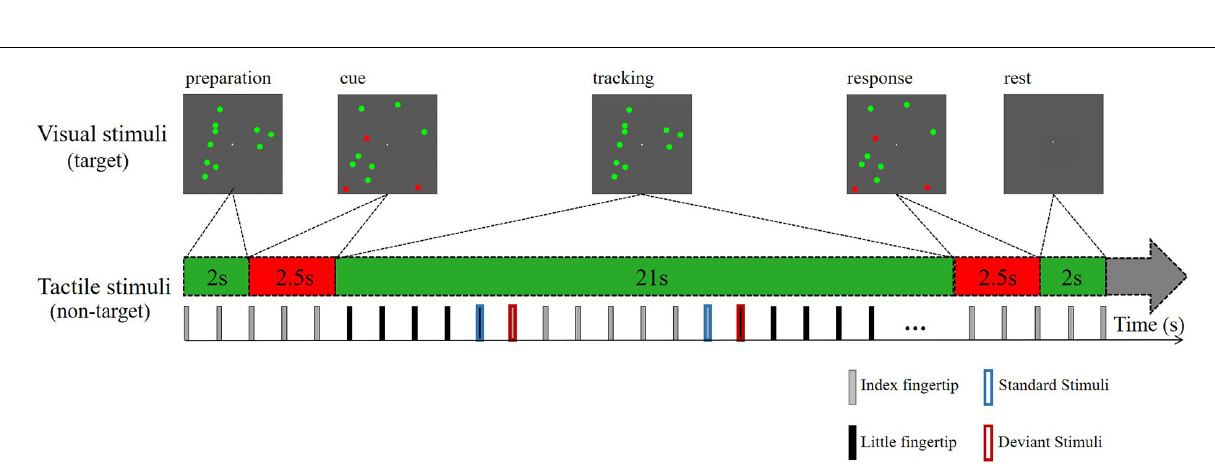
FIGURE 1 | (A) Experiment 1 consisted of four types of blocks according to the different difficulties of visual materials. The house images were photos taken in Okayama City. The face images were obtained from the FEI face database (https://fei.edu.br/ ∼ cet/facedatabase.html). (B) Each block consisted of 600 trials, including 60 deviant stimuli and 60 standard stimuli. The visual stimuli and tactile stimuli were presented simultaneously.